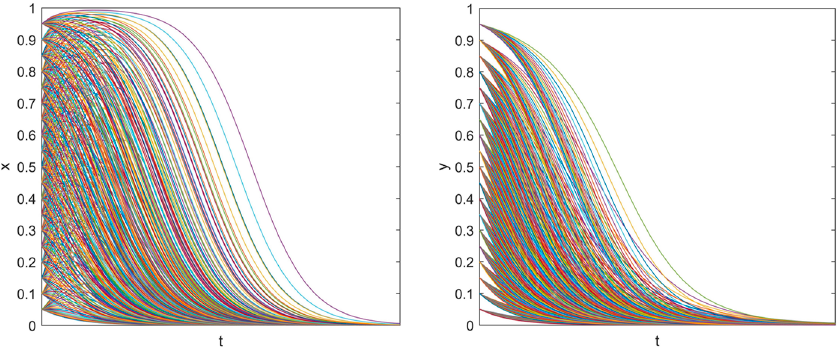
Figure 7. Strategies’ evolutions of the grid company and user over time in Case 2.